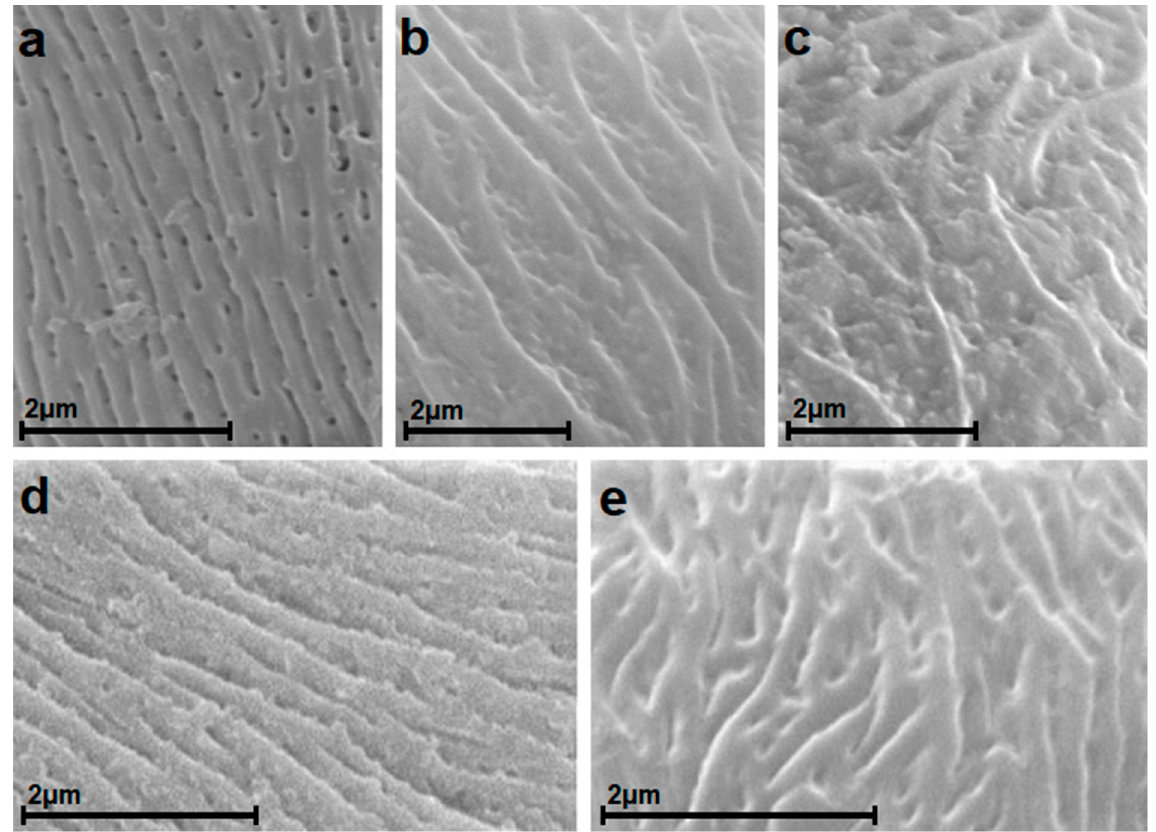
Figure 6. Striate exine ornamentation types according to Ueda and Tomita (1989); see Table 6. Rubus